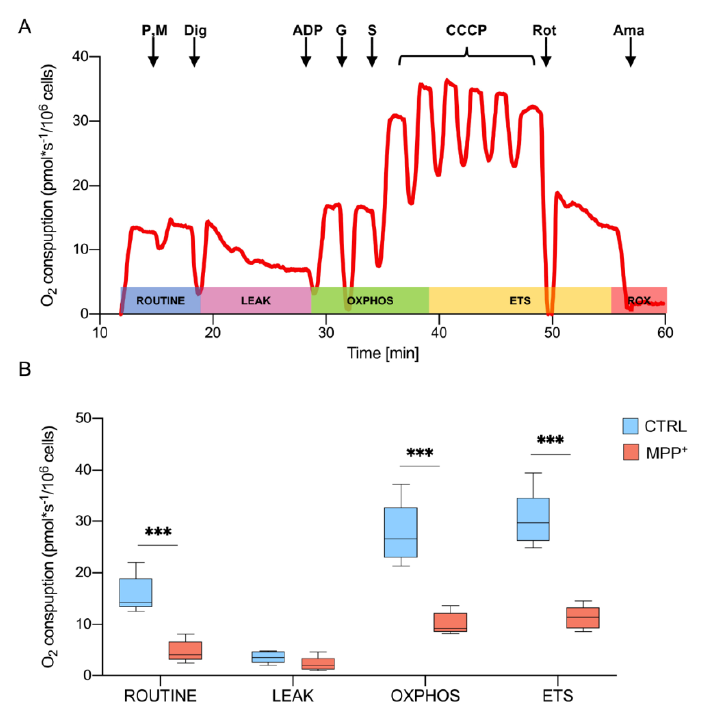
Figure 2. Oxygen consumption in differentiated SH-SY5Y cells. ( A ) The representative curve of mitochondrial respiratory function of untreated RA-differentiated SH-SY5Y cells assayed in MiR05 respiration medium at 37 °C. The respiratory states ROUTINE, LEAK, OXPHOS, ETS, and ROX were analyzed after the addition of specific substrates and inhibitors. P, pyruvate; M, malate; Dig, digitonin; G, glutamate; S, succinate; Rot, rotenone; Ama, antimycin. ( B ) Quantitative analysis of the oxygen consumption rate expressed as pmol/second per million cells of control and MPP + treated cells calculated for ROUTINE, LEAK, OXPHOS, ETS. Data are shown as mean with standard deviation, with *** p < 0.001.